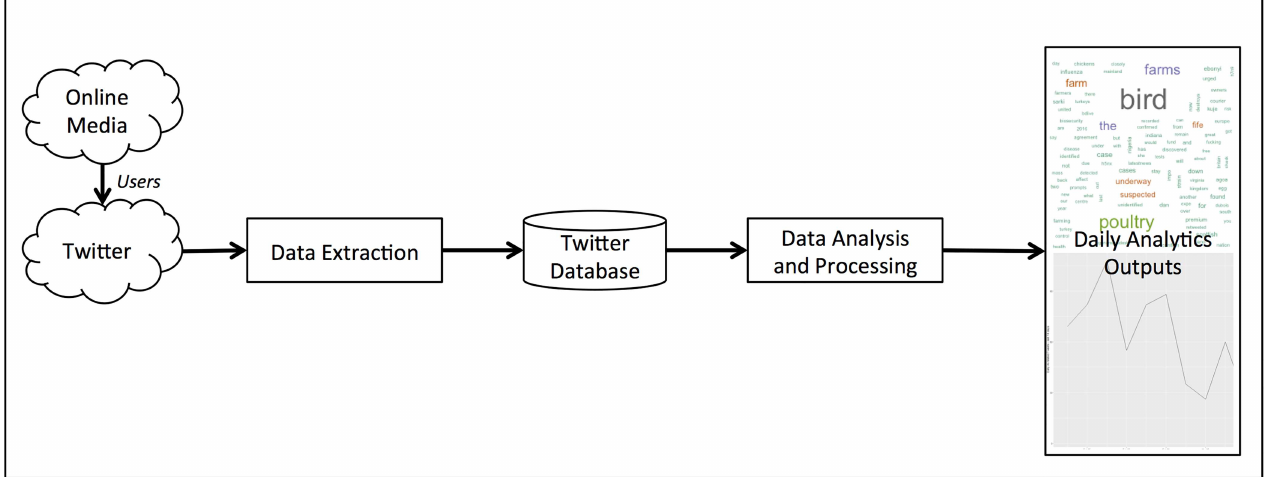
Fig 1. Data acquisition and processing pipeline